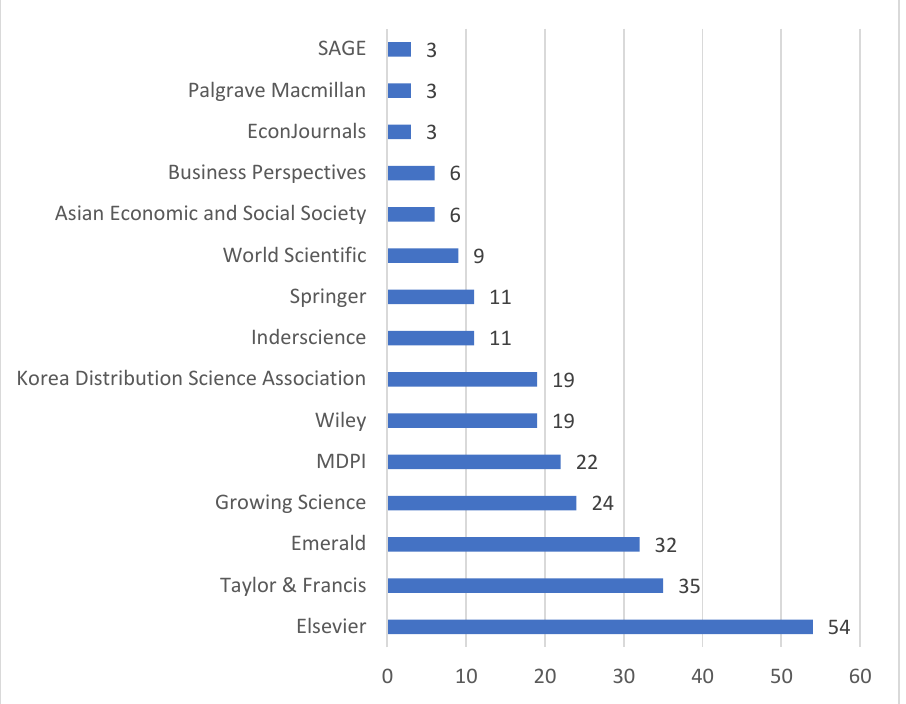
Figure 1. Characteristics of 314 publications from the final sample.